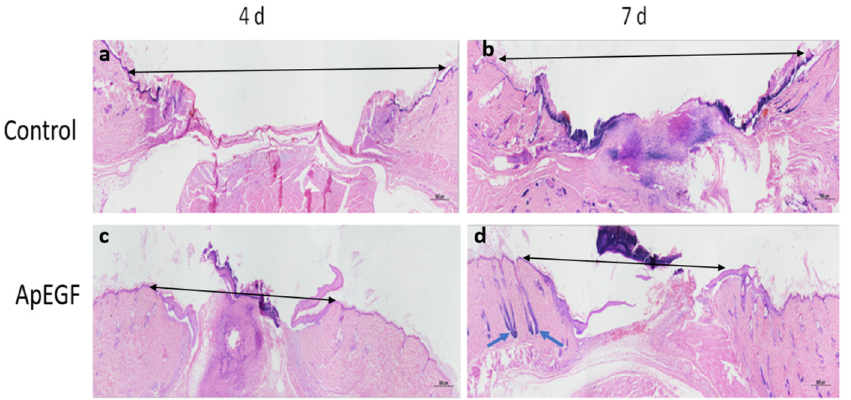
Figure 6. Wound-healing effect of the control and truncated ApEGF in vivo . A 1 × 1 cm circular wound was cut behind the skin on the back of the SD rat. The animals were divided into two groups, the normal group (0.9% NaCl 0.2 mL) and the experimental group (30 μ g/0.2 mL cut-off EGF of A. pernyi ). The drug was administered every morning and afternoon, and wound photographs were taken every 3 days.